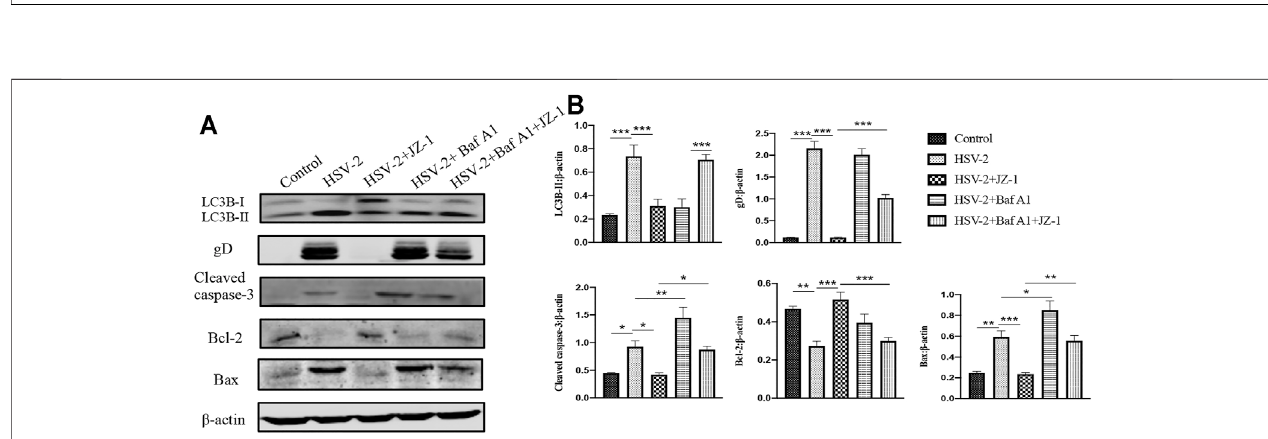
FIGURE 7 | JZ-1 inhibits PI3K/Akt/mTOR pathway in HSV-2-induced GH. (A) Representative western blots for p-PI3K, PI3K, p-Akt, Akt, p-mTOR, and mTOR in vulvaofdifferentgroups. (B) Thequanti fi cationofp-PI3K,PI3K,p-Akt,Akt,p-mTOR,andmTORwesternblots.Alldataarepresentedasmeans ± SEM. p < 0.01(**),and p < 0.001 (***); ( n (cid:2) 6).